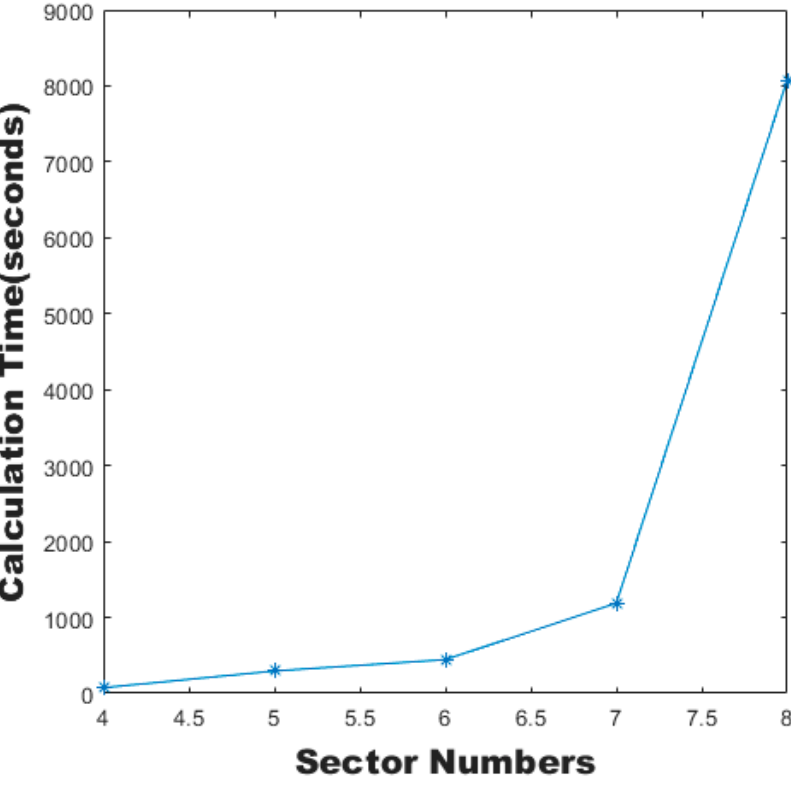
Figure 22. Calculation time of the MC-CLFV algorithm with different sector numbers.